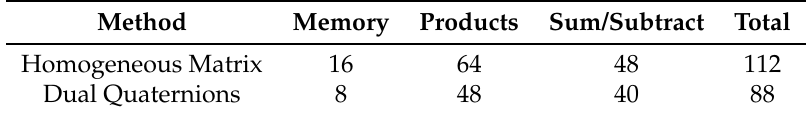
Table 2. Number of operations between Denavit–Hartenberg and dual quaternions.